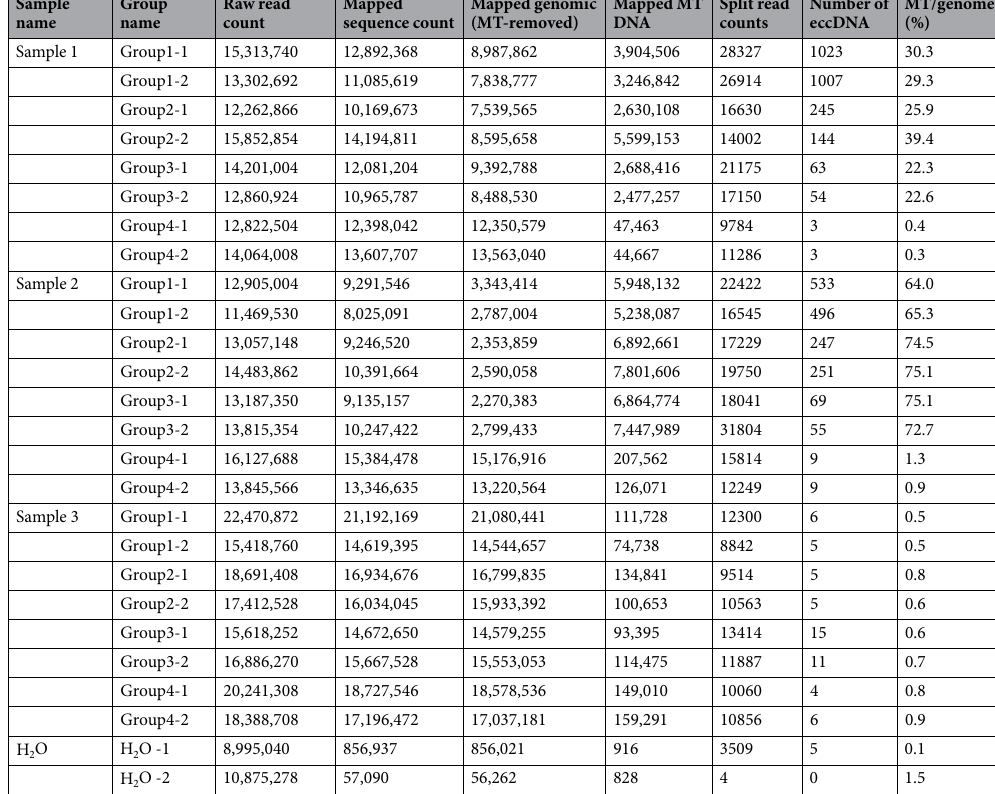
Table 1. Statistical summary of eccDNA sequencing data in samples 1, 2, 3 and negative